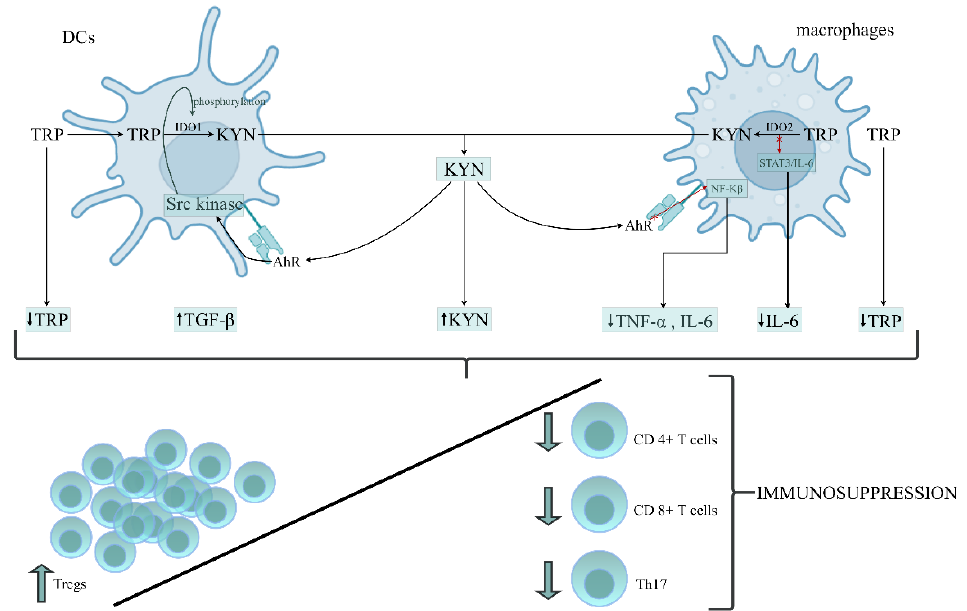
Figure 2. The proposed role of tryptophan (TRP) metabolism by the kynurenine pathway (KP) in the leading cells of innate immunity during the generation of immunosuppres- sion/immunoparalysis during sepsis. DCs and macrophages belong to the APCs that mediate the cellular immune response by processing and presenting antigens for recognition by particular subsets of T cells. The activation of IDO1 and IDO2 in APCs initiates the metabolism of TRP via the kynurenine pathway, resulting in depletion of TRP and accumulation of kynurenine (KYN) in the immune cells’ environment. KYN, through AhR activation, can affect the different intracellular signalling pathways in DCs and macrophages, increasing the anti-inflammatory response and parallelly decreasing the proinflammatory response of these cells. Depletion of TRP and proin- flammatory cytokines (IL-6, TNF- α), which is associated with the generation of KYN and anti - inflammatory cytokines, like TGF- β, creates an environment conducive to the origination o f im- munotolerogenic Tregs with a simultaneously reduced number and function of Th17, cytotoxic CD4+ and CD8+ T cells, leading to an overall impairment of immune functions and immunosup- pression development. Abbreviations: DCs — dendritic cells; APCs — antygen presenting